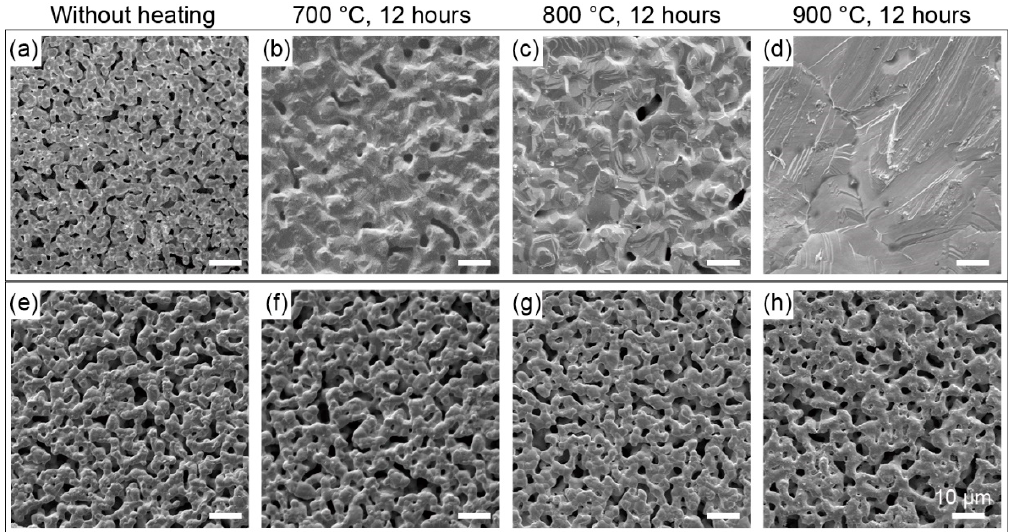
Figure 3. FESEM images of pure silver and SDC-infiltrated silver membranes at different heating temperature for 12 h. ( a ) Pure silver membrane without heating and heated at ( b ) 700 °C, ( c ) 800 °C, and ( d ) 900 °C. ( e ) SDC-infiltrated silver membrane without heating and heated at ( f ) 700 °C, ( g ) 800 °C, and ( h ) 900 °C.